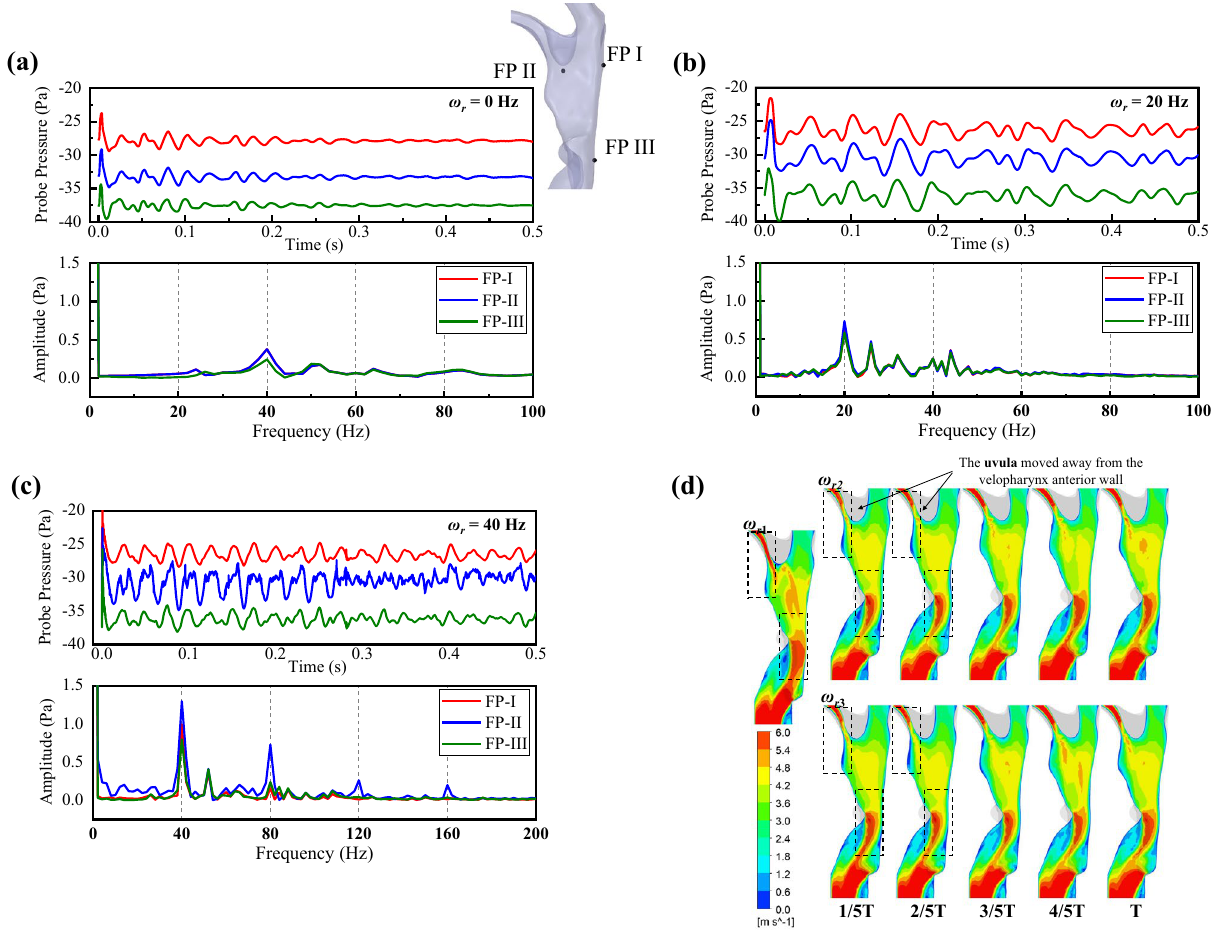
Figure 2. Detailed comparison of the flow field for varying uvula flapping frequencies. ( a – c ) Time history signals and corresponding FFT analyses of three pressure probes (FP I, II, and III) at three flapping frequencies. The time-averaged pressure on FP I, II, and III are as follows. ω r 1 : − 27.865 Pa, − 33.265 Pa, and − 37.508 Pa. ω r 2 : − 26.317 Pa, − 30.517 Pa, and − 36.108 Pa. ω r 3 : − 26.537 Pa, − 30.551 Pa, and − 36.166 Pa. ( d ) Airflow velocity contours in the midsagittal plane of the pharyngeal